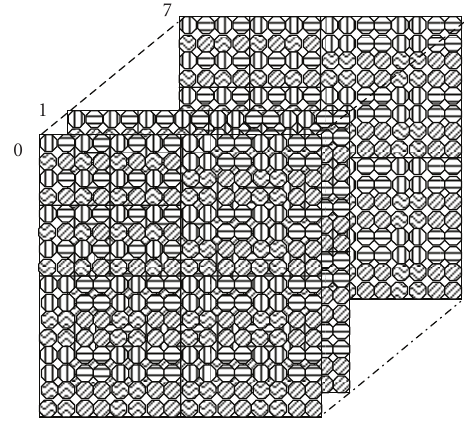
Figure 2: An example of partitioning strategy.